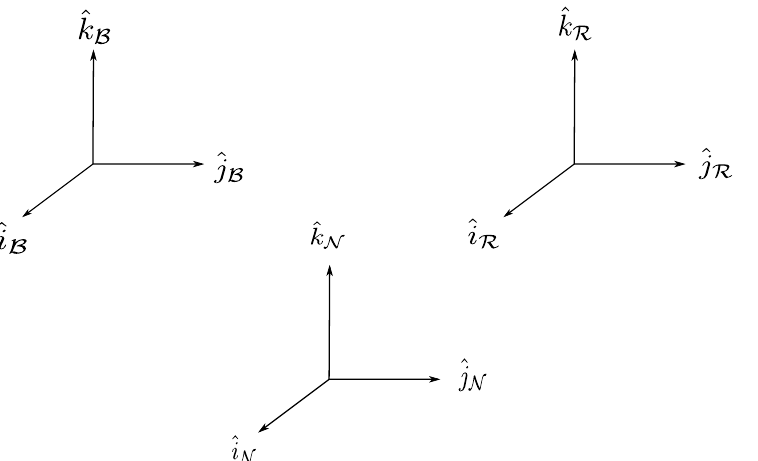
Figure 4. The relative coordinate system, with the inertially fixed earth axis N , reference trajectory R , and spacecraft body B .